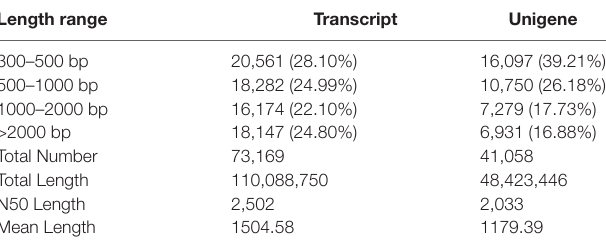
TABLE 3 | Transcripts and unigenes statistical information. Length range Transcript Unigene 300–500 bp 20,561